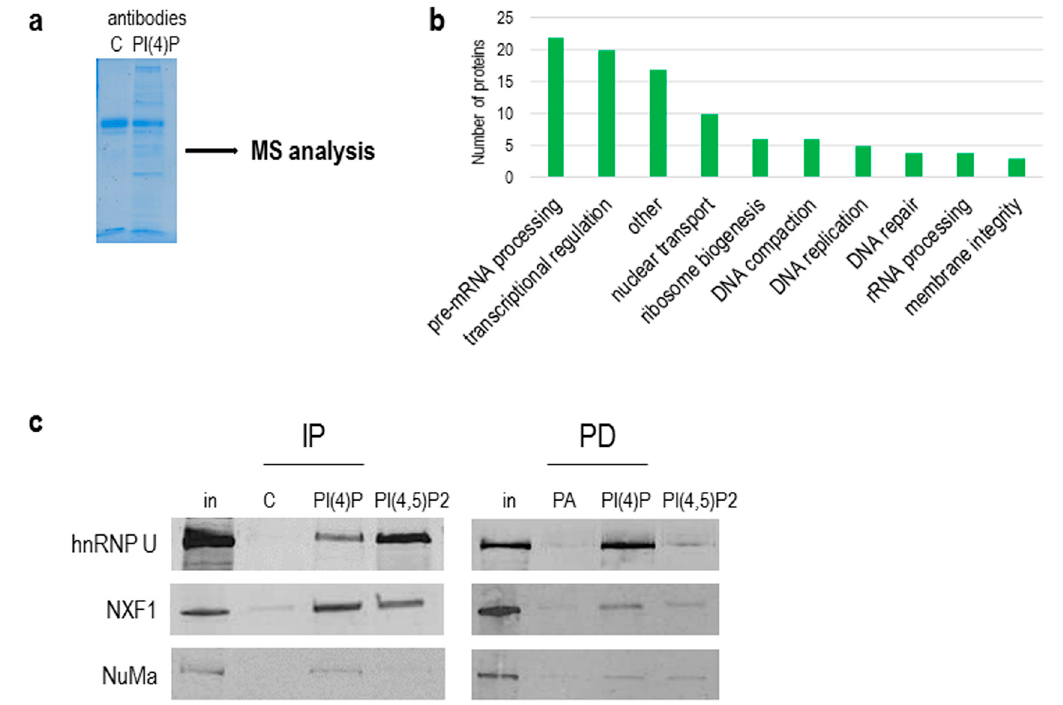
Figure 7. PI(4)P forms lipid–protein complexes in the nucleus. ( a ) PI(4)P-binding partners were immunoprecipitated with anti-PI(4)P antibody, and the gel was stained with Coomassie Blue; MS—mass spectrometry. ( b ) The graph shows a number of proteins identified by mass spectrometry, divided into different sub-groups based on their function in the nucleus (uniprot.org). ( c ) Example of proteins immunoprecipitated with anti-PI(4)P and anti-PI(4,5)P2 antibody (IP) and pulled down with PI(4)P/PI(4,5)P2-coated agarose beads (PD). Ten percent of an input nuclear lysate was loaded on the gel in rows “in”. In—input; C—control mouse IgM antibody; PA—phosphatidic acid-coated agarose beads; hnRNP U—heterogeneous nuclear ribonucleoprotein U; NXF1—nuclear RNA export factor 1; NuMa—nuclear mitotic apparatus protein 1.